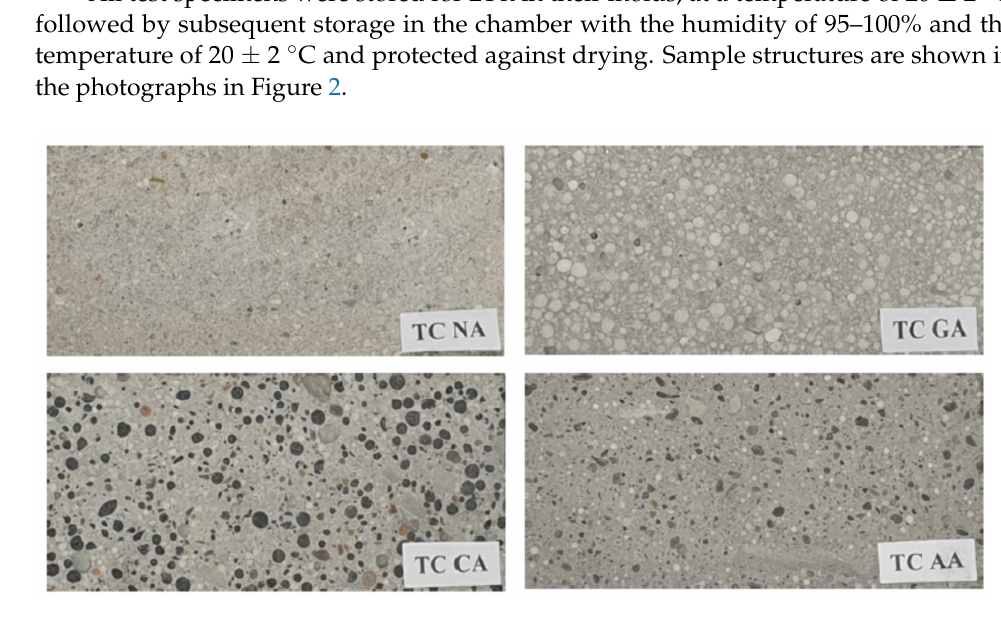
Figure 2. Sample